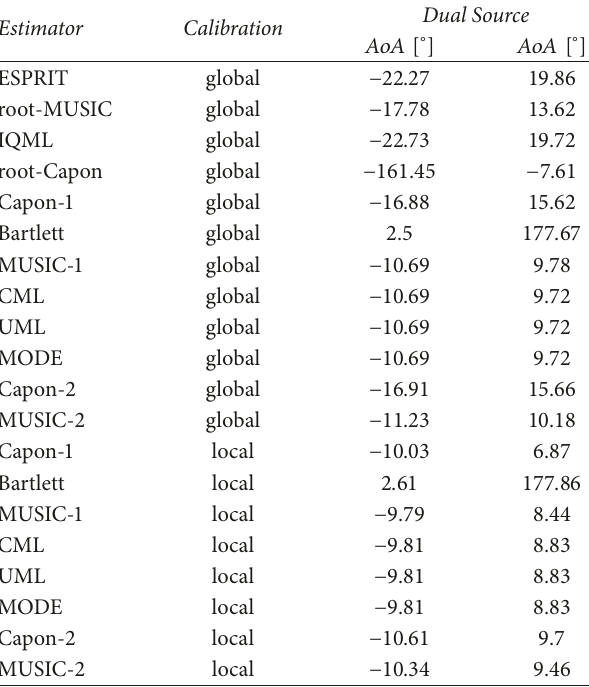
Table 7: Estimated AoAs under global and local array calibration. The setup is a coherent dual source ( − 10 ∘ , 8 ∘ )